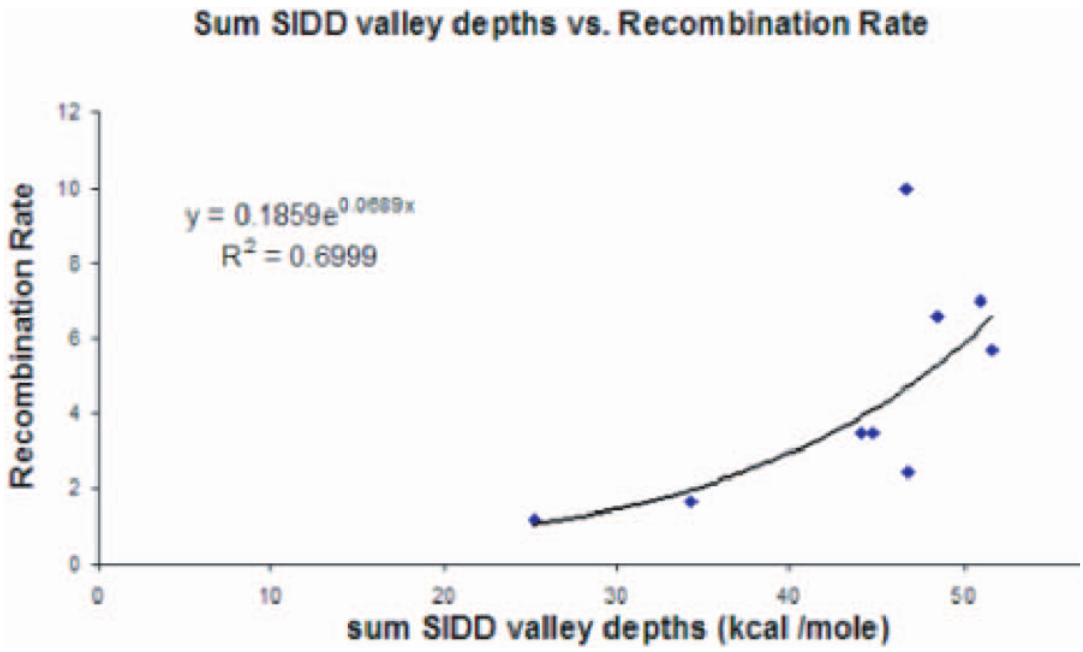
Figure 6. The scatter-plot is shown of the sums of the SIDD valley depths (in units of G ( x ) in kcal/mole) vs. the recombination rate for each of the nine plasmid inserts.